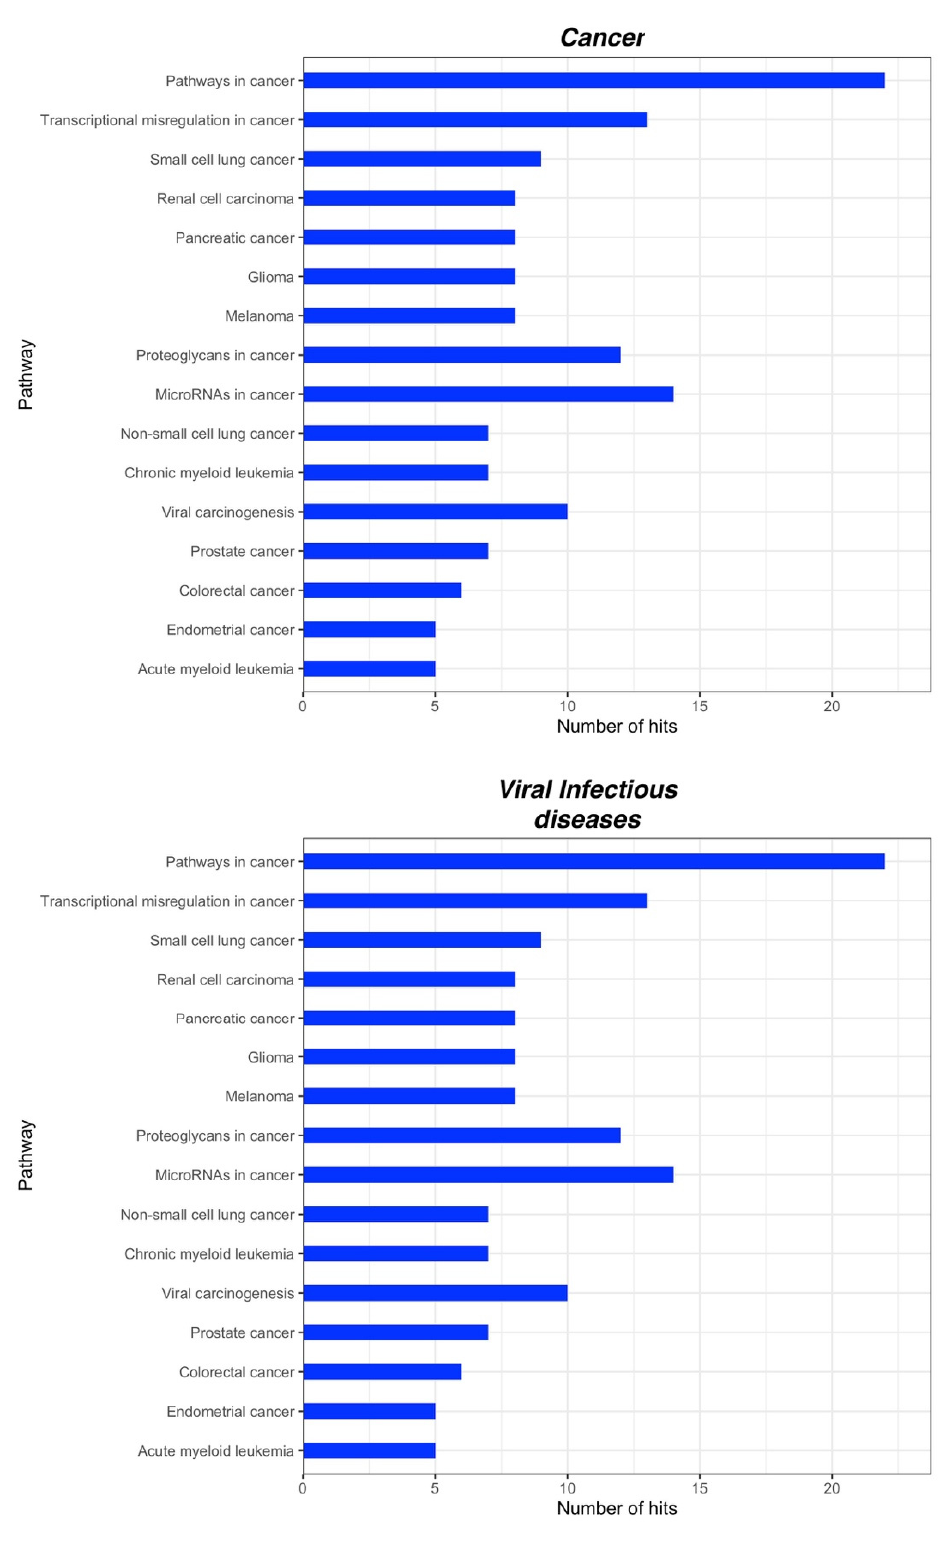
Figure 5. KEGG pathways related to diseases significantly associated with miRNA targets in CSP CSP (within each group, pathways are arranged according to their p -values, in descending order). (within each group, pathways are arranged according to their p-values, in descending order). Ad- Adjusted p -values were calculated using Benjamini-Yekutieli justed p -values were calculated using Benjamini-Yekutieli method.